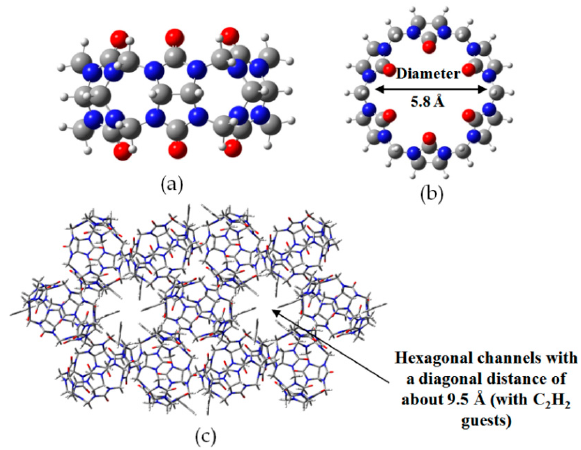
Figure 13. Side ( a ) and top view ( b ) of CB[6]; ( c ) The porous crystalline network of H12 .